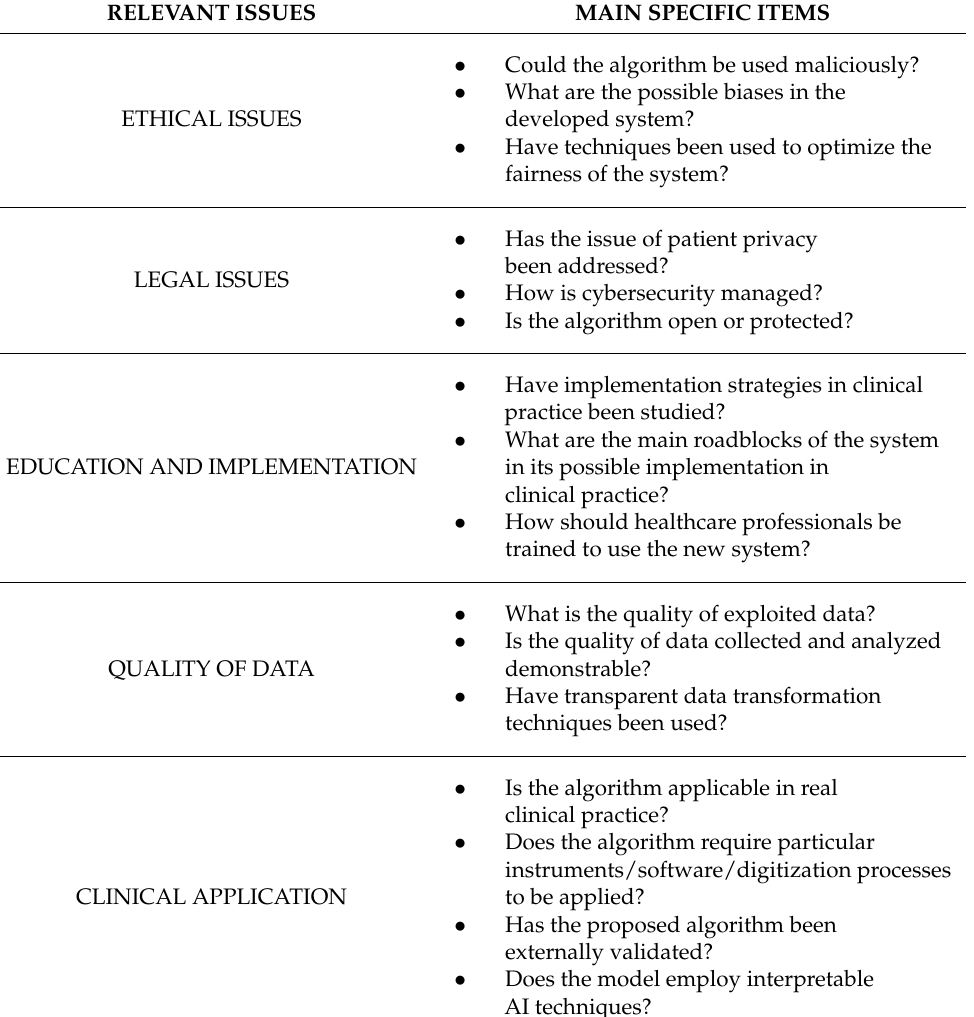
Table 1. Relevant issues and main specific